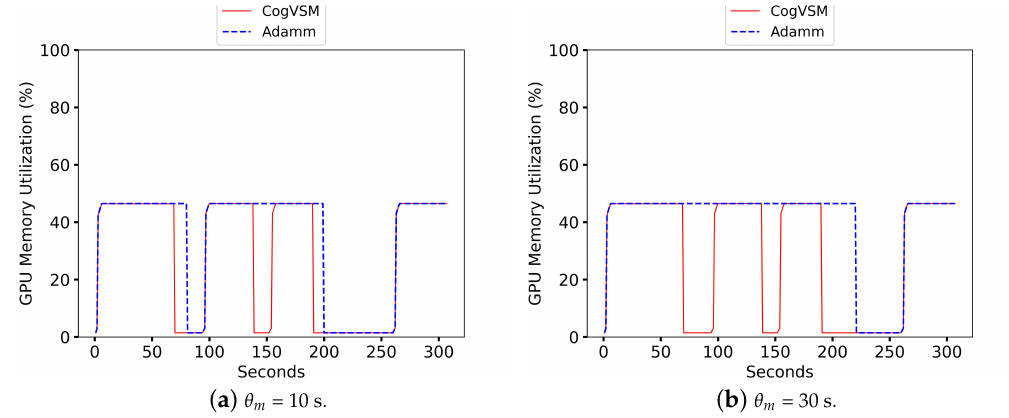
Figure 7. Comparison of Proposed CogVSM framework and AdaMM framework in terms of GPU memory utilization on 2nd edge